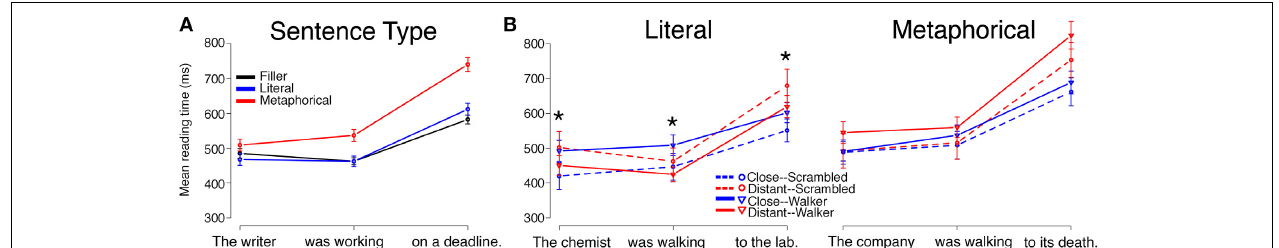
FIGURE 3 | Reading times for sentence regions from the Motion Group in Experiment 2 are displayed by (A) Sentence Type and (B) by Verb Match and Prime Type for Literal and Metaphorical sentences. Error bars represent standard errors of the mean. Interactions between Verb Match and Prime Type at the critical (second) region,